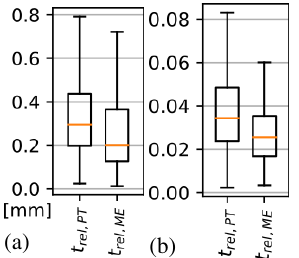
Figure 16. (a) Boxplots of absolute errors; (b) boxplots of relative errors for a relative rotation angle of 5° for 3D